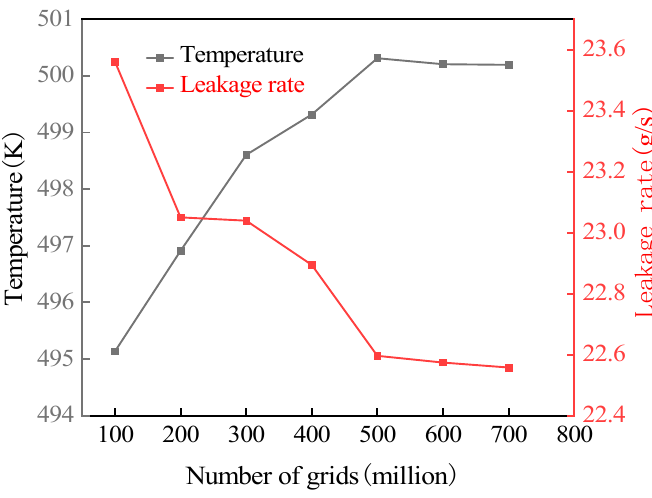
Figure 4. Calculation results for different number of grids.